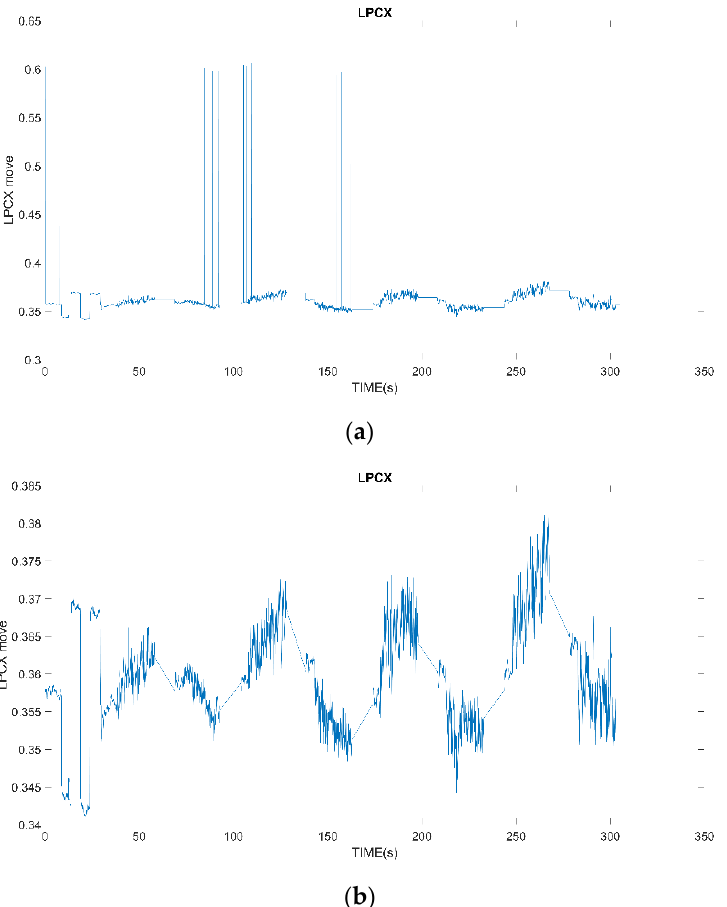
Figure 4. ( a ) Original data; ( b ) Noise filtered data.